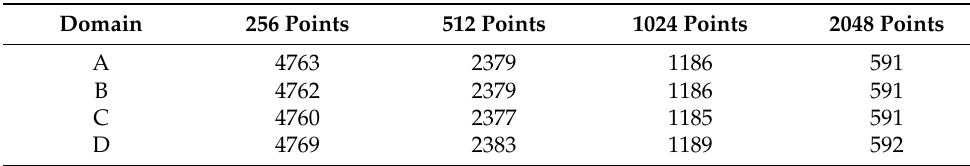
Table 3. Description of the samples of the four signal lengths.